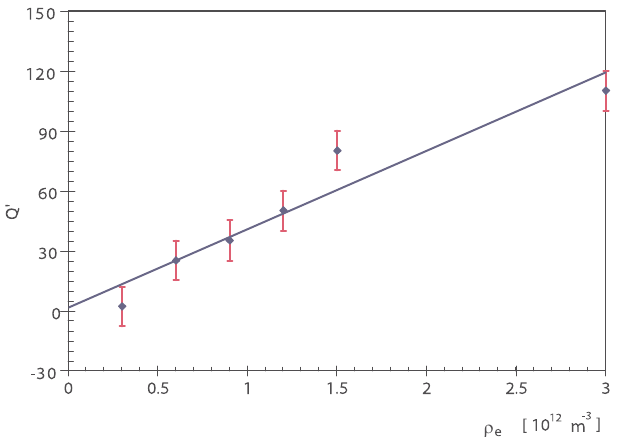
FIG. 13. (Color) Vertical emittance as a function of time, for varying longitudinal bunch extent, number of slices and number of macroprotons.